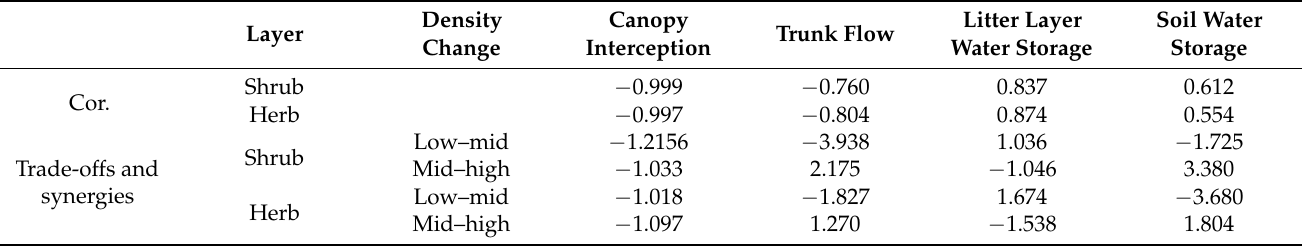
Table 6. Trade-offs and synergies between plant species diversity and water retention capacity in the shrub layer and herb